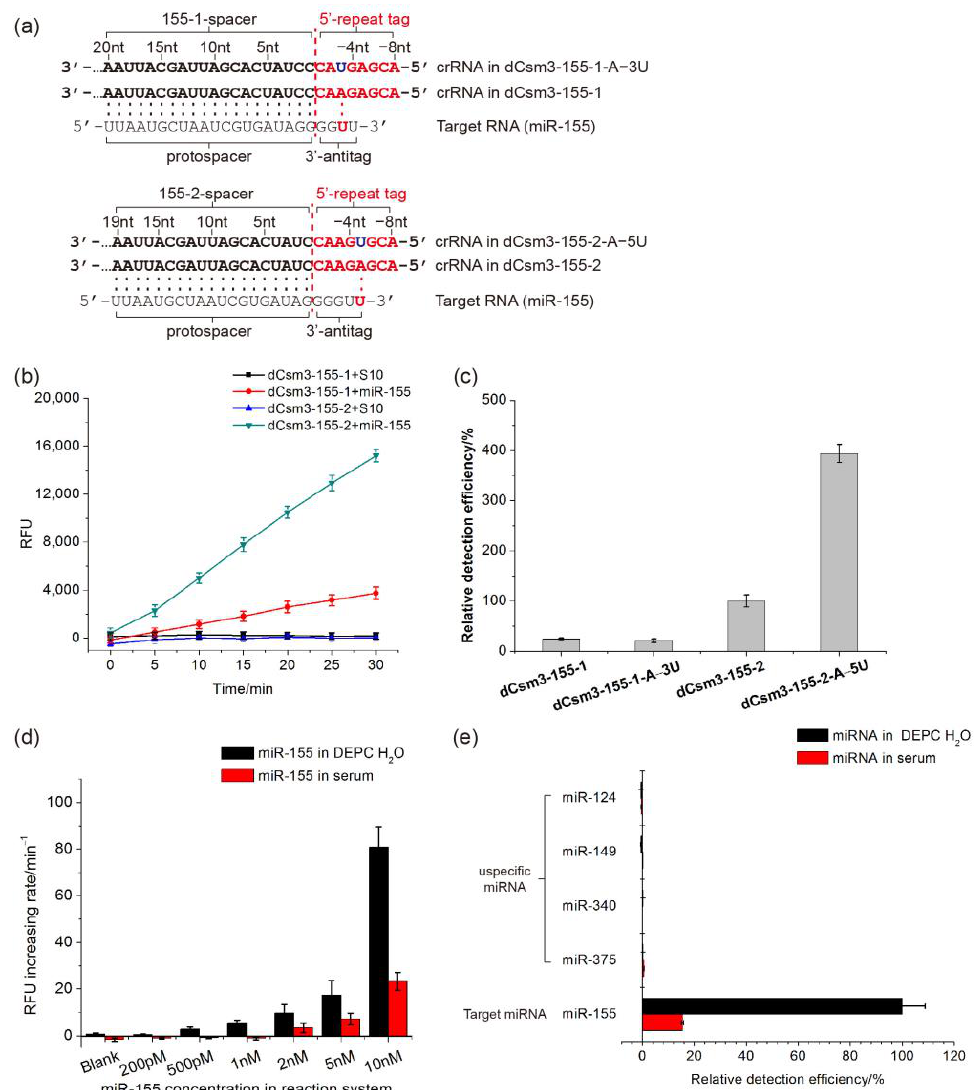
Figure 6. Detection of miR-155 by using the LdCsm-dCsm3 detection system. ( a ) Schematic of the two crRNAs designed for miR-155 detection (155-1 and 155-2) and their repeat-mutated derivatives (155-1-A − 3U and 155-2-A −5U). 5′ -repeat tags of crRNAs are highlighted in red. Base pairings between 3′ -antitag of miR-155 and the 5 ′ -repeat tag of each crRNA are highlighted in red; mutated bases in the repeat tags are shown in dark blue. ( b ) Time course experiment of miR-155 detection by LdCsm-dCsm3 carrying crRNAs derived from the 155-1 or 155-2 spacer (denoted as dCsm3-155-1 or dCsm3-155-2, respectively). ( c ) Relative detection activity of four LdCsm-dCsm3 effectors carrying each of the four designed spacers. Detection activity of dCsm3-155-2 was set as 100%. ( d ) Specific detection of miR-155 in clinic mimic samples. ( e ) Specificity of dCsm3-155-2-A − 5U. Target miRNA miR-155 or unspecific miRNAs including miR-124, miR-149, miR-340, and miR-375 (sequences listed in Table S3) were each dissolved in the DEPC H 2 O or in human sera. The final concentration of miRNAs in these reaction systems is 10